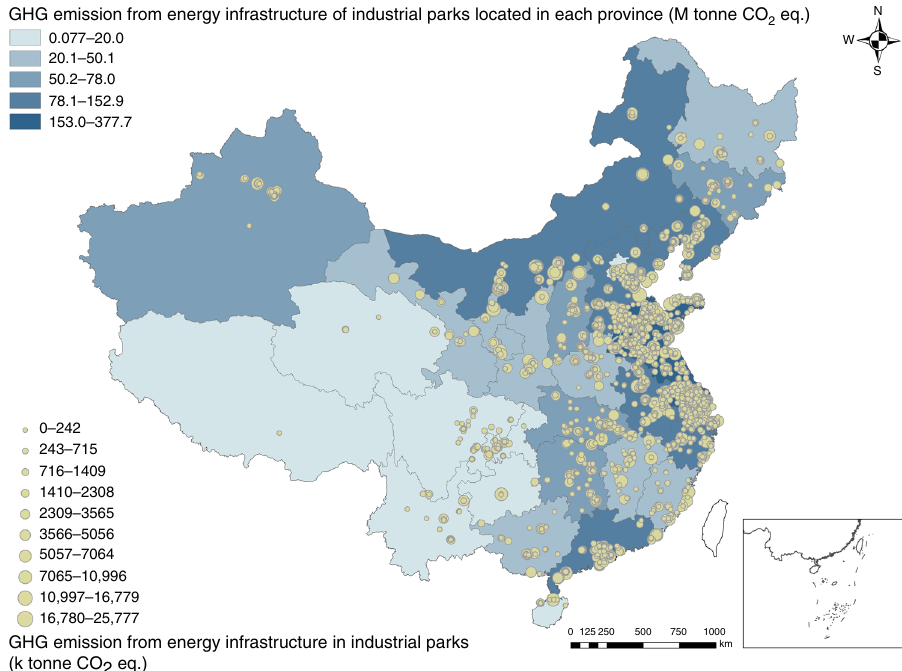
Fig. 2 GHG emissions from energy infrastructure in the 1604 Chinese industrial parks. The beige circle symbol size is proportional to the greenhouse gas (GHG) emissions from energy infrastructure in industrial parks, and the color depth is positively correlated with the GHG emissions from energy infrastructure of industrial parks in each provincial area. Source data are provided as a Source Data fi le.